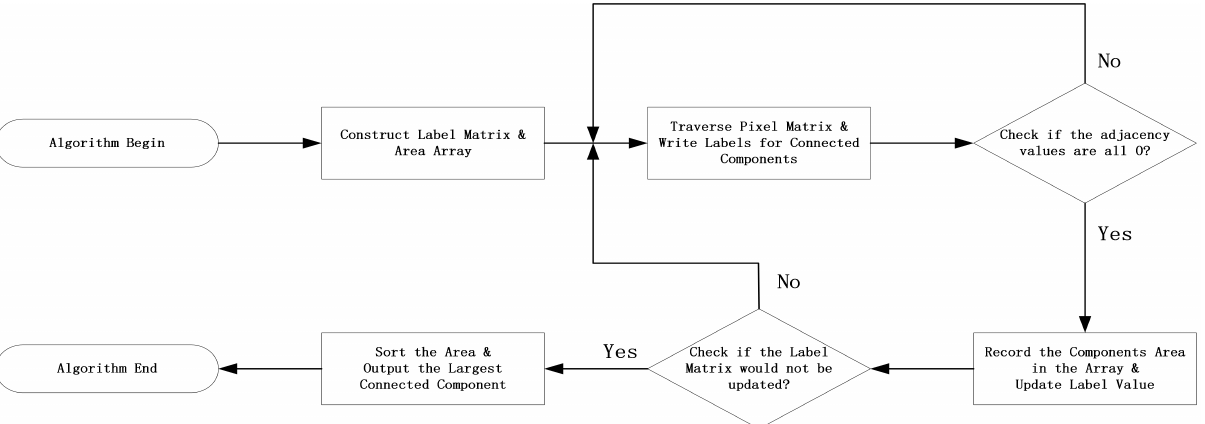
Figure 8. Flowchart of the eight-neighborhood maximum connected component extraction algorithm.